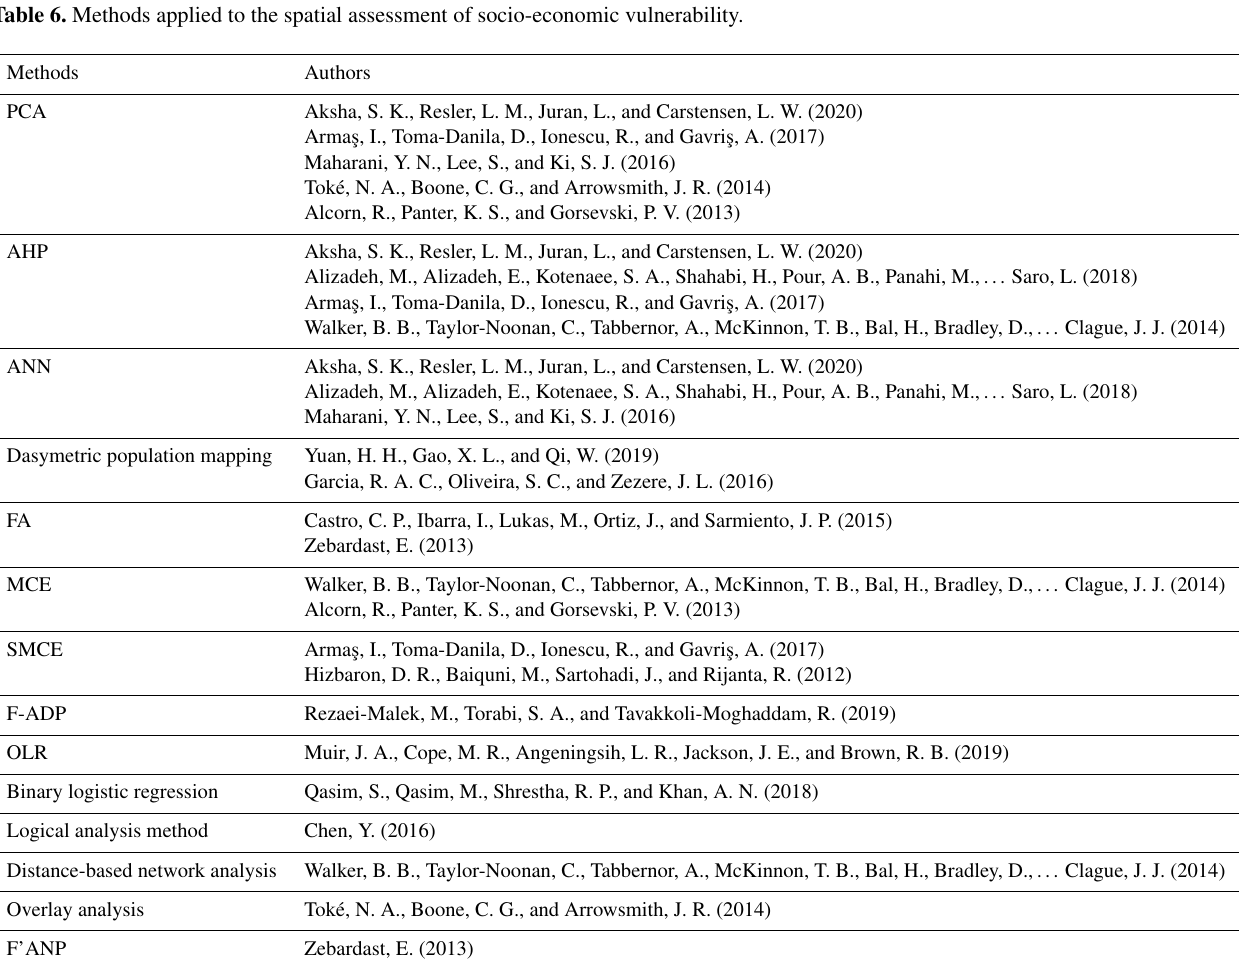
Table 6. Methods applied to the spatial assessment of socio-economic